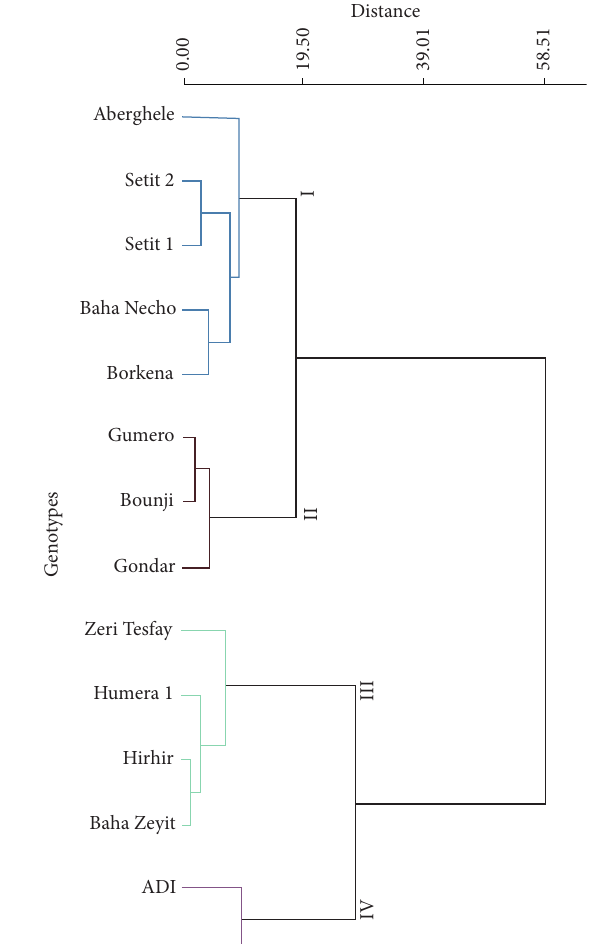
Figure 2: Dendrogram using Ward’s method based on dissimilarity matrix of 14 sesame ( S. indicum L .) genotypes from the Tigrai Biotechnology Center, Ethiopia.